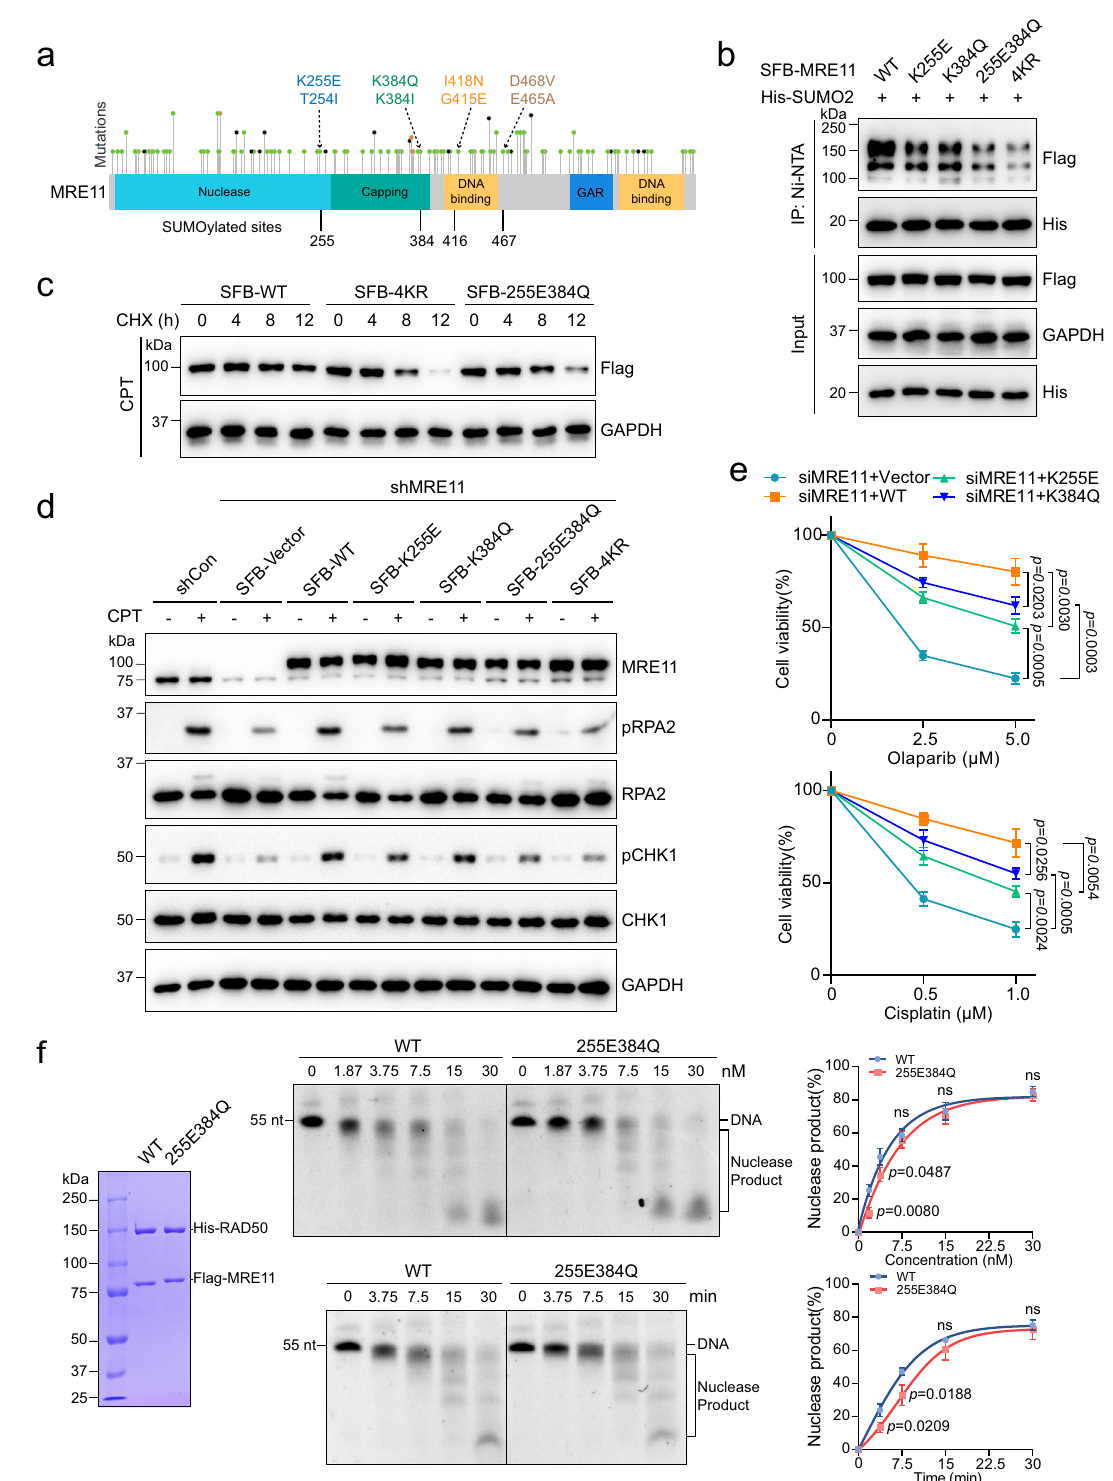
Fig. 8 | MRE11 SUMOylation defects relate to cancer development. a Overlap between MRE11 SUMOylation sites and disease-related mutation sites. MRE11 mutation sites were collected from the ClinVar and cBioPortal databases. b The cancer-related MRE11 mutants showed a decrease in SUMOylation. c 255E384Q mutant was easier to degrade after the treatment of CPT (1 μ M, 4h). d HeLa cells expressing the cancer-related MRE11 mutants exhibited defects in RPA2